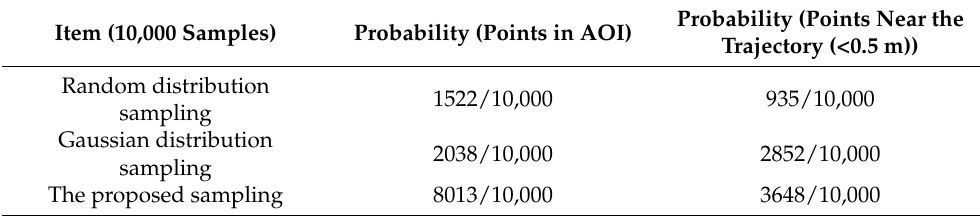
Table 7. The sampling efficiency analysis results of the three